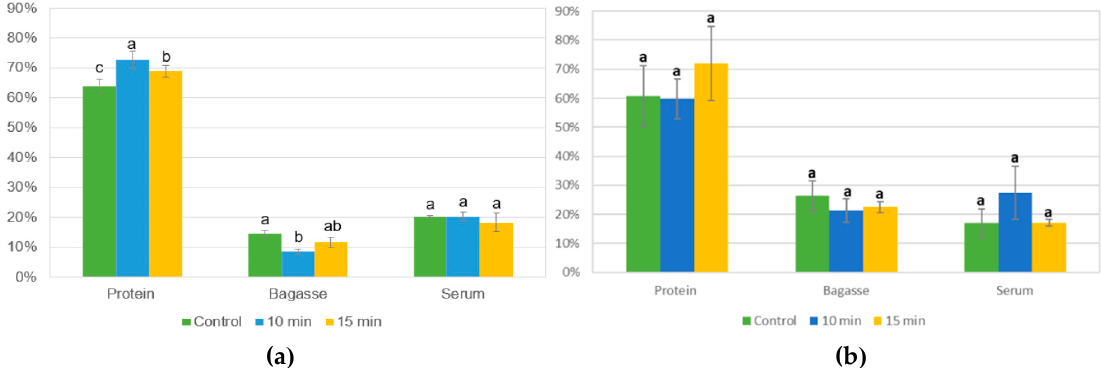
Figure 7. ( a ) L. mutabilis and ( b ) L. angustifolius protein extraction yield (%) for each fraction (protein curd, bagasse, and serum) obtained during the alkaline process assisted with US followed by isoelectric precipitation. Bars with di ff erent letters within evaluated fraction are statistically di ff erent ( p < 0.05). For L. mutabilis samples, significant statistical di ff erences were observed between protein curd and bagasse. The results of L. angustifolius showed that there was no significant di ff erence between